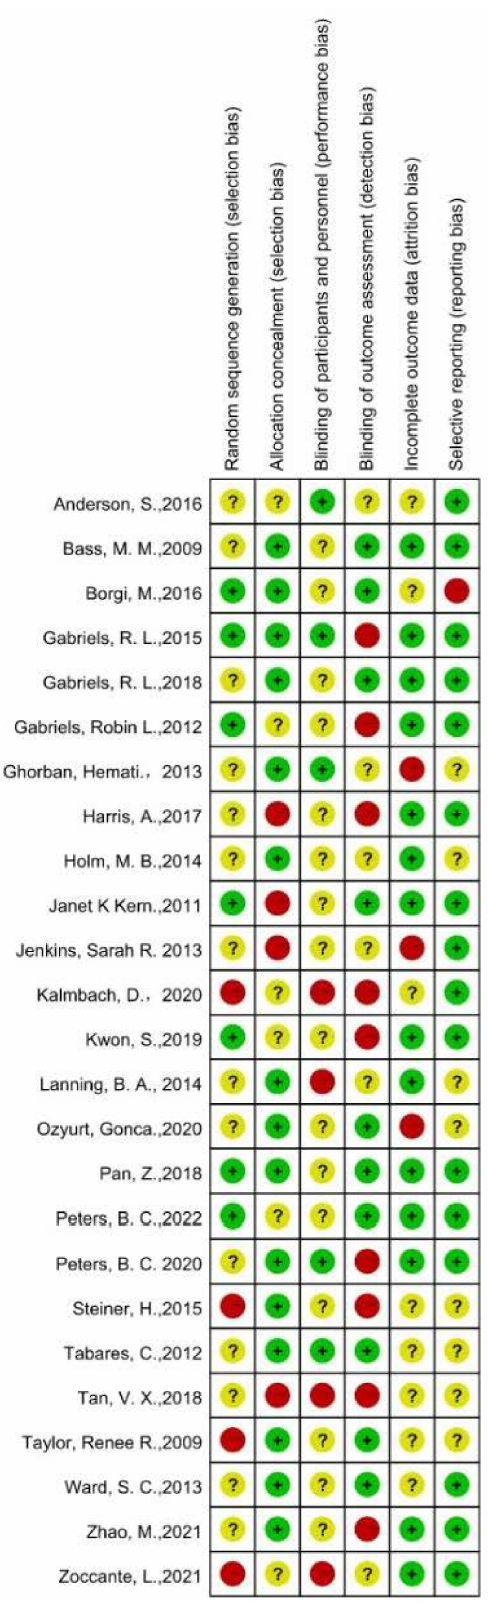
Figure 2. Risk of bias summary